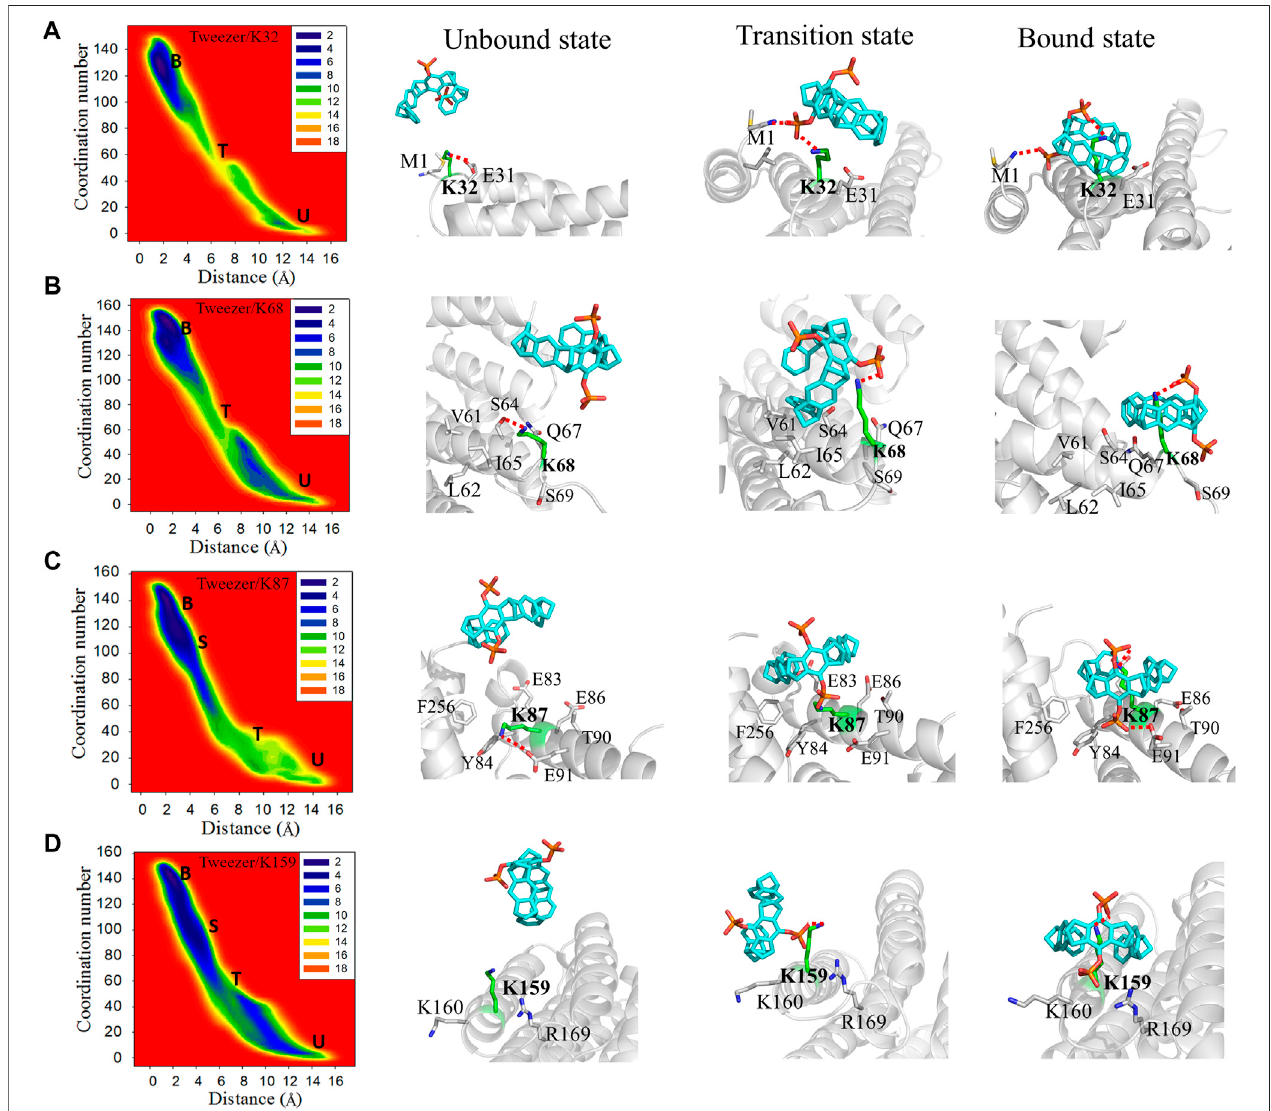
FIGURE4 | Two-dimensional freeenergy landscapes and representativestructures for thebindingof thetweezer to (A) K32, (B) K68, (C) K87, and (D) K159. The symbols “ U ” , “ T ” , “ S ” , and “ B ” in the free energy landscapes represent the unbound, transition, semi-bound, and bound states, respectively. Additionally, the representative structures of the unbound state, transition state, and bound state for the tweezer to these lysine residues are shown on the right side of the free energy landscapes. The superimposed structures of these states for each binding site are depicted in Supplementary Figure S12 .